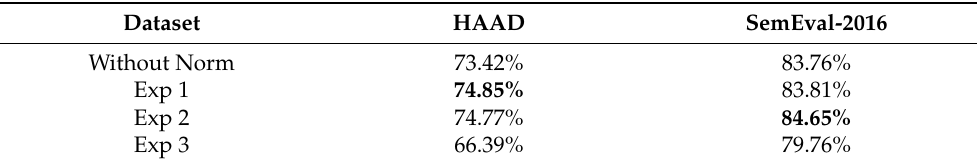
Table 7. Performance results on T2 using HAAD and SemEval-2016 datasets for the three experiments. Accuracy metric was used.